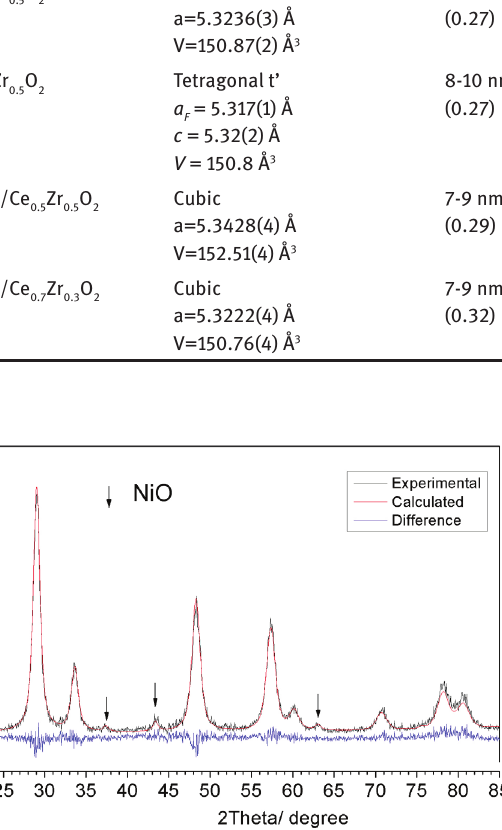
Figure 3: Full-profile Rietveld refinement for 5%Ni/Ce sample.